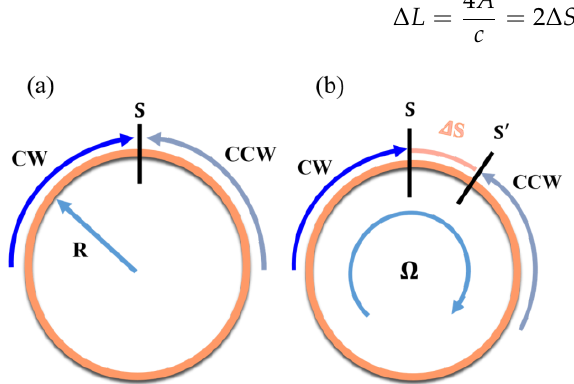
Figure 3. Schematic diagram of the Sagnac effect in a circular light path: ( a ) the circular optical path is stationary; ( b ) the optical path rotates along clockwise with angular velocity Ω